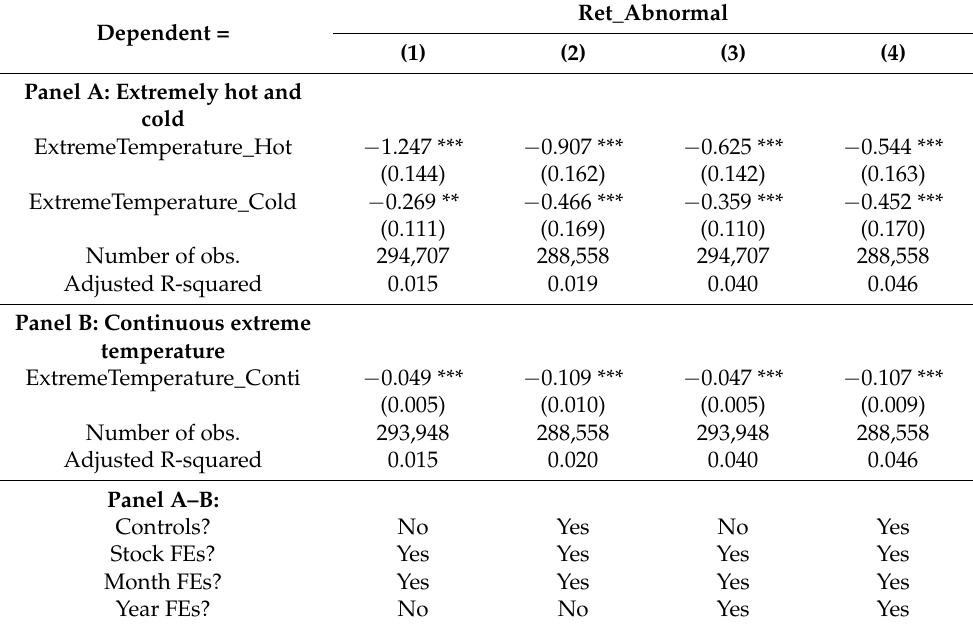
Table 15. Alternative specifications of extreme